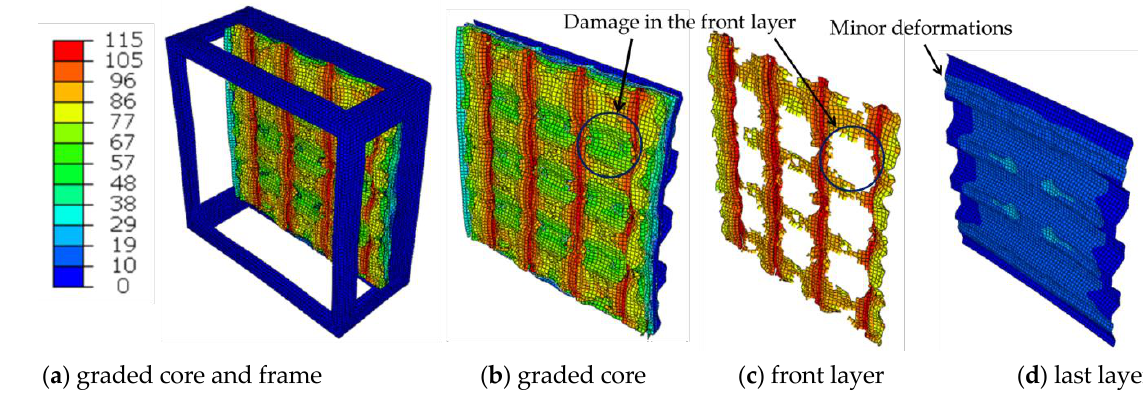
Figure 14. Peak deformations (mm) of the graded sandwich panel showing frontal layer damage and last layer minor deformations, when subjected to 0.5 kg of TNT at R = 0.5 m (BI-5). ( a ) graded core and frame; ( b ) graded core; ( c ) front layer; ( d ) last layer.